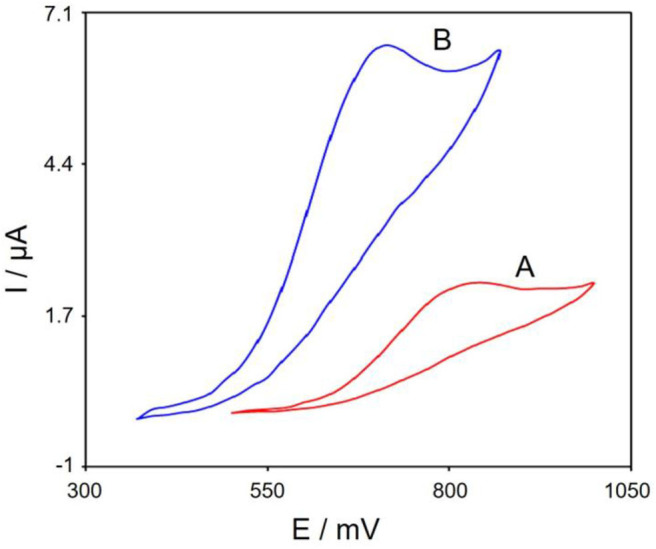
The CVs of (A) bare SPE, (B) Gr/Co3O4/SPE in 0.1 M PBS at pH of 7.0 when 100.0 μM tramadol is present at 50 mVs−1 scan rate.